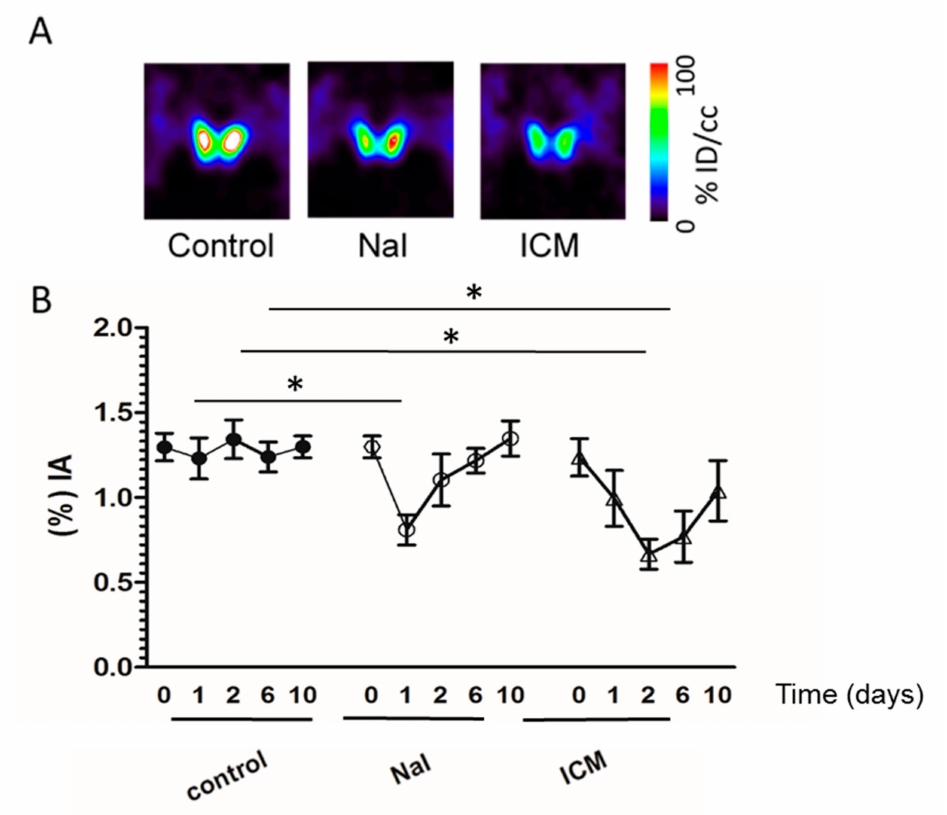
Figure 2. E ff ect of ICM and NaI on the uptake of 99m perctechnetate by the mouse thyroid. SPECT / CT imaging of mice administered 20 MBq 99m pertechnetate was performed (day 0). At the end of the scan, ICM or NaI was administered. One, two, six and ten days later, animals were injected with 20 MBq 99m pertechnetate and new scans were performed. ( A ) Representative microSPECT / CT images of thyroid uptake 24 hours after NaI treatment and 48 hours after ICM treatment. ( B ) The data represent the percentage of radiotracer injected taken up by the thyroid before treatment (0) and after one, two, six or ten days treatment with NaI (open circle) or ICM (open triangles). Uptakes in control thyroids are shown (filled circles). (n = 3 per condition). Significant di ff erences (one-way ANOVA) in thyroid uptake are shown. Asterisks (* p < 0.05 versus control group) indicate results of post-hoc test (Bonferroni); % IA: percentage of the injected activity.